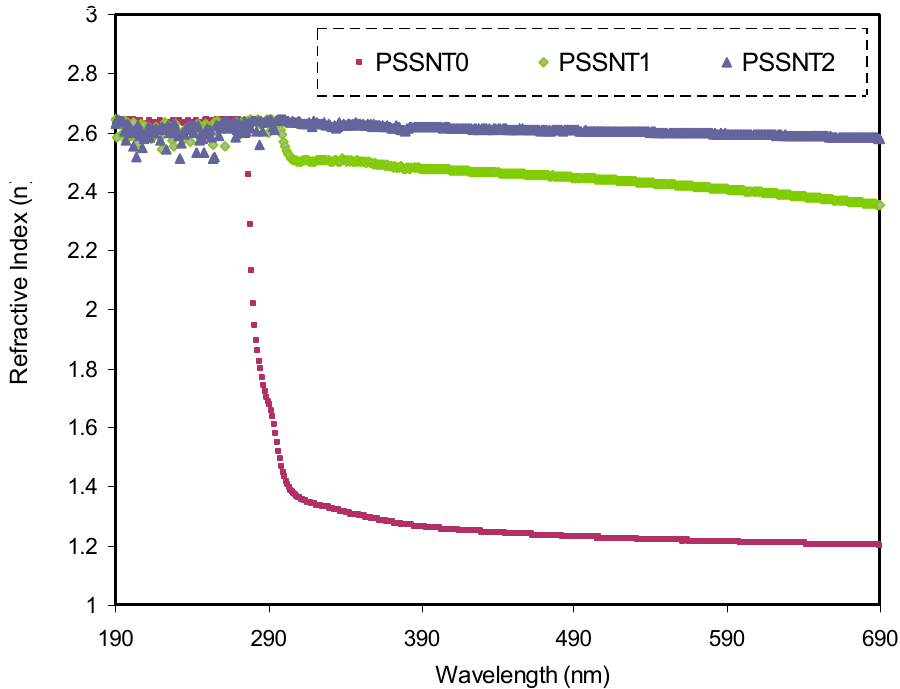
Figure 5. Refractive index spectra versus wavelength for pure PS (PSSNT0), PSSNT1, and PSSNT2 composite films. Table 4. Measured refractive index for different polymer composites.